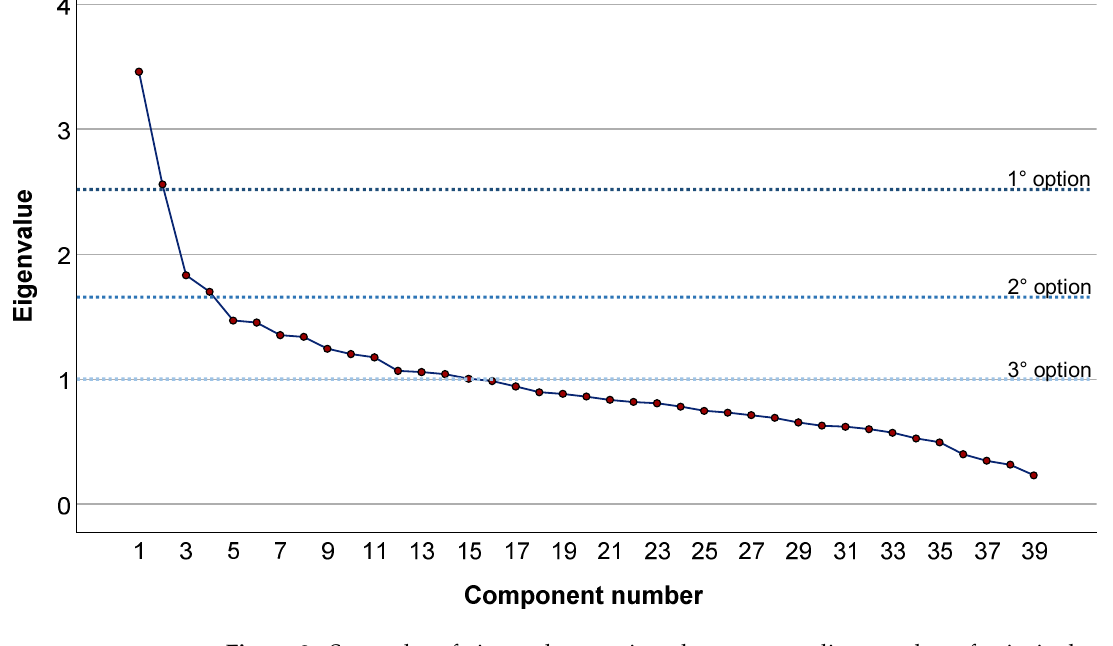
Figure 2. Scree plot of eigenvalues against the corresponding number of principal components. Dotted lines represent three options for selecting the number of principal components to be retained.